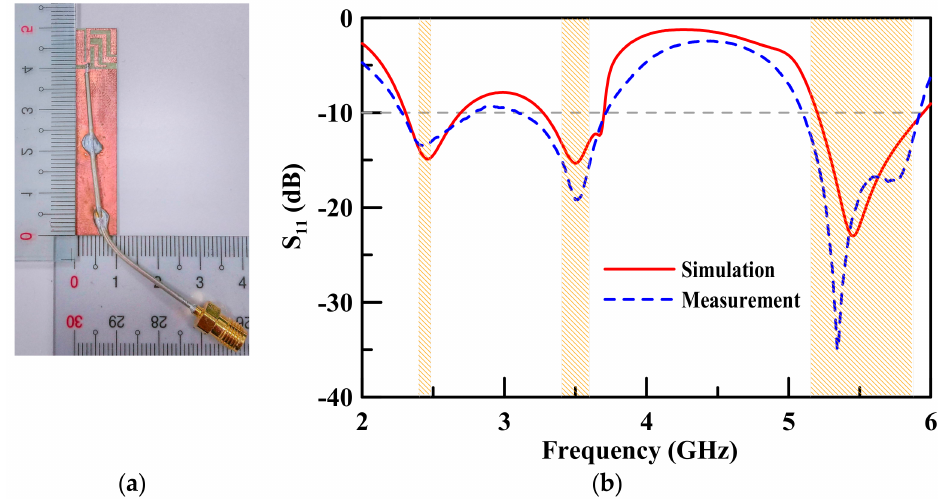
Figure 10. ( a ) Sample of the fabricated antenna; ( b ) comparison of the simulation results and the theoretical measured results in terms of return loss.